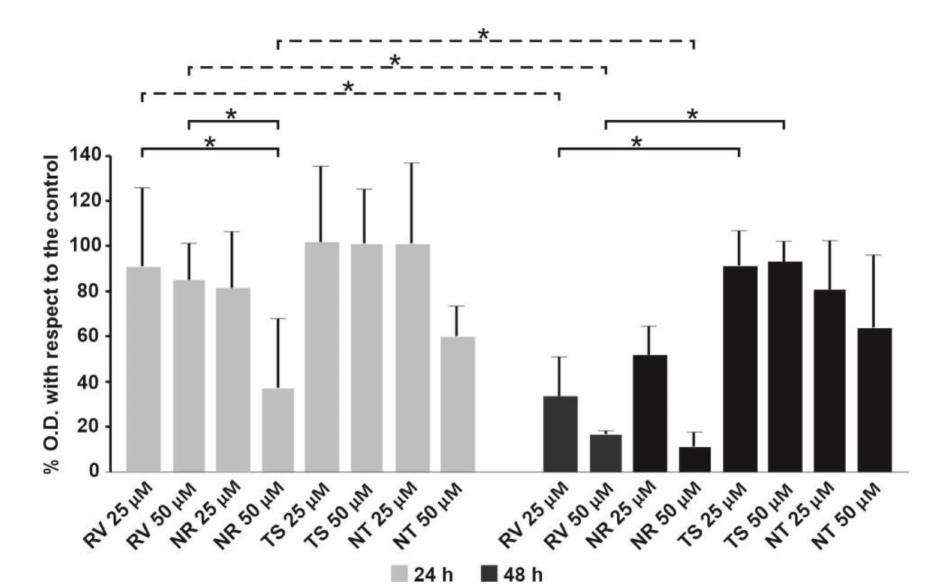
Figure 7. Toxicity towards T24 cells treated with RV and TS (alone or loaded in NEs at distinct concentrations) for 24 and 48 h measured by MTT assay. * p <